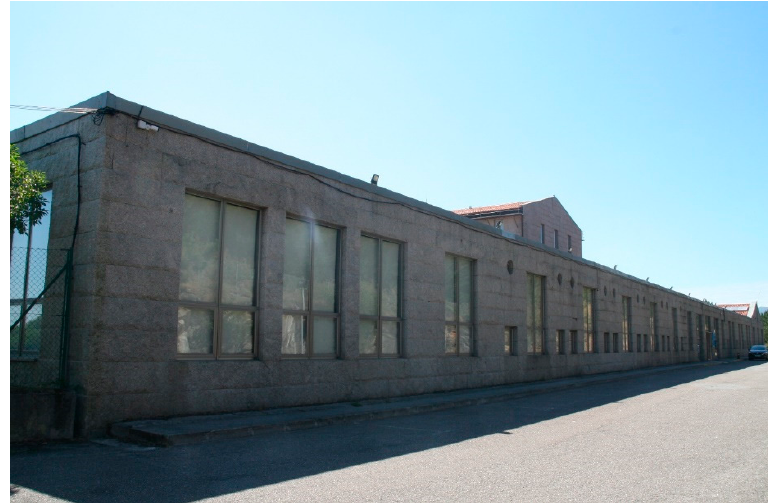
Figure 7. General view of the Fishery Training School, Punta de Niño do Corvo, Arousa, designed by Pascuala Campos de Michelena (Authorship: AFC).